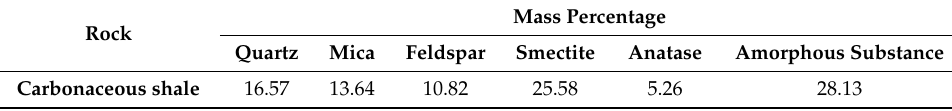
Figure 1. Small modified portable drilling rig in the jobsite. Table 1. X-ray di ff raction (XRD) analysis results of mineral composition of carbonaceous